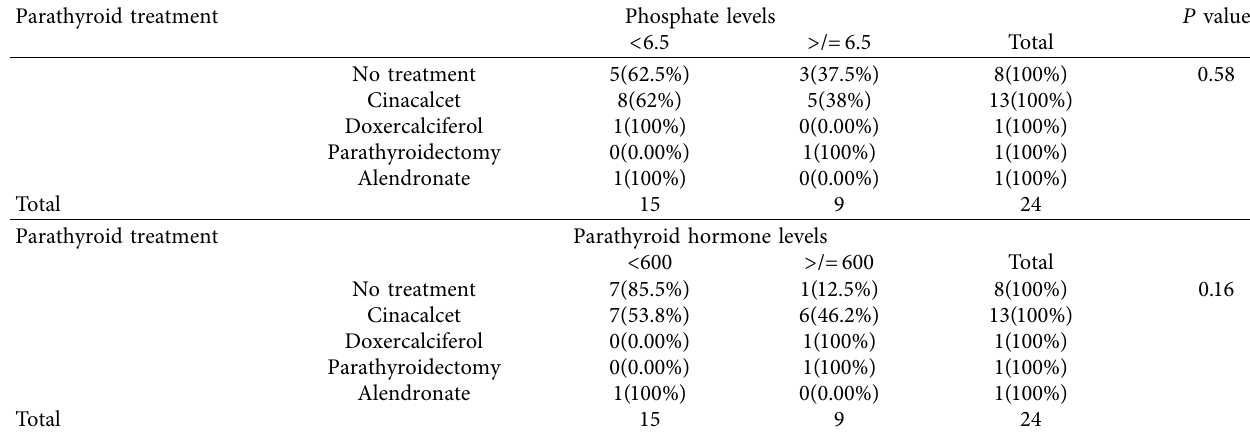
Table 5: The relation of parathyroid treatment to the degree of hyperphosphatemia and parathyroid hormone levels. Parathyroid treatment Phosphate levels